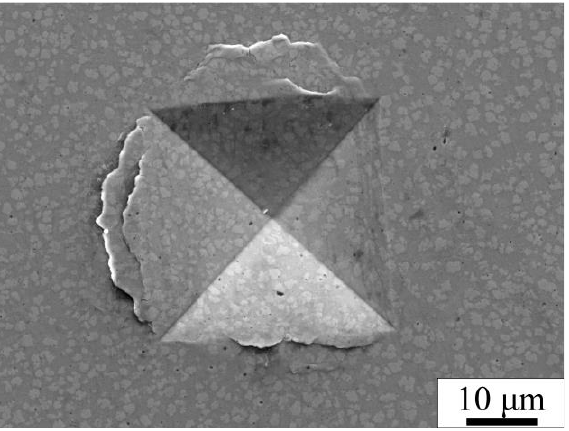
Figure 7. SEM secondary electron image of the indentation site showing circumferential cracks without the presence of radial cracks.